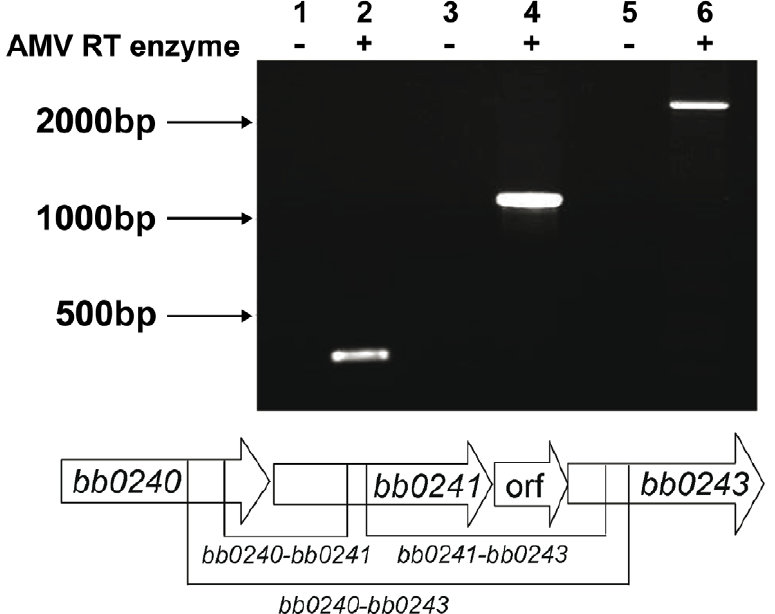
Figure 3. The B.burgdorferiglp region constitutes an operon. RT-PCR of RNA extracted from B31-A3 grown at 37 u C in BSK-II medium was performed using primers listed in table 4. Lanes 1, 2: bb0240 - bb0241 (expected size 349 bp); lanes 3, 4: bb0241 – bb0243 (expected size 1141 bp); lanes 5, 6: bb0240 – bb0243 (expected size 2383 bp). Migration positions of DNA size markers are indicated on left. A schematic diagram showing the operon structure and sizes of expected amplification products is shown below the gel picture.